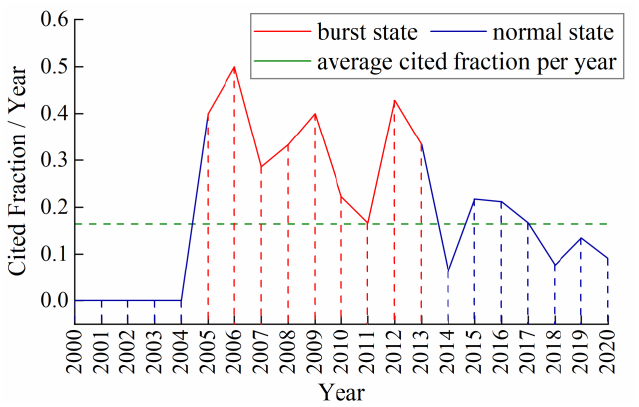
Figure A2. An example of co-authorship analysis results. The burst detection algorithm proposed by Kleinberg [115] can detect significant changes in the frequency of keywords or terms over a short period of time. A detected burst term has two features: burst strength and burst duration. High burst strength indicates a remarkable aggregation of research interest in the detected terms. Moreover, burst duration is defined with reference to the beginning and ending year of the burst state, as shown in Figure A3. The application of burst detection can reveal the explosion, evolution, and decline of the concern for research themes and accordingly facilitate the identification of research fronts in an academic field.